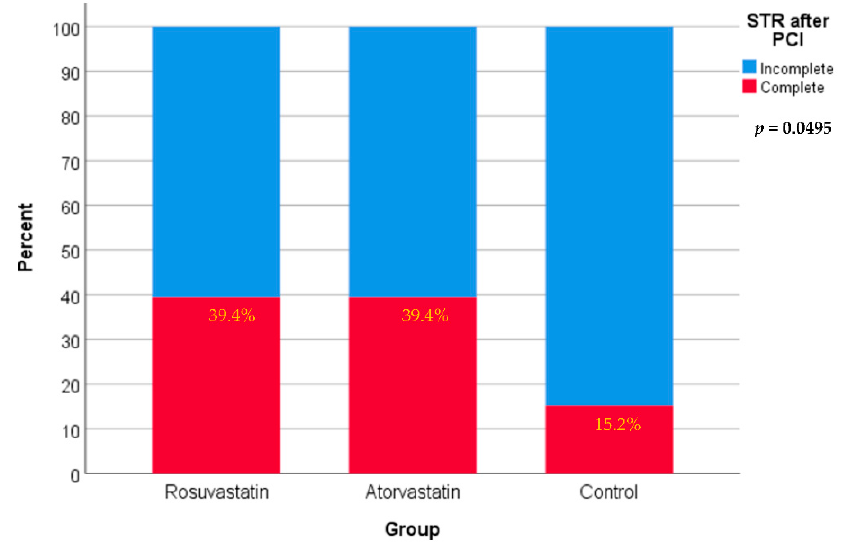
Figure 3. STR (ST-segment resolution) after PCI in the three study groups using the Pearson chi- square test.